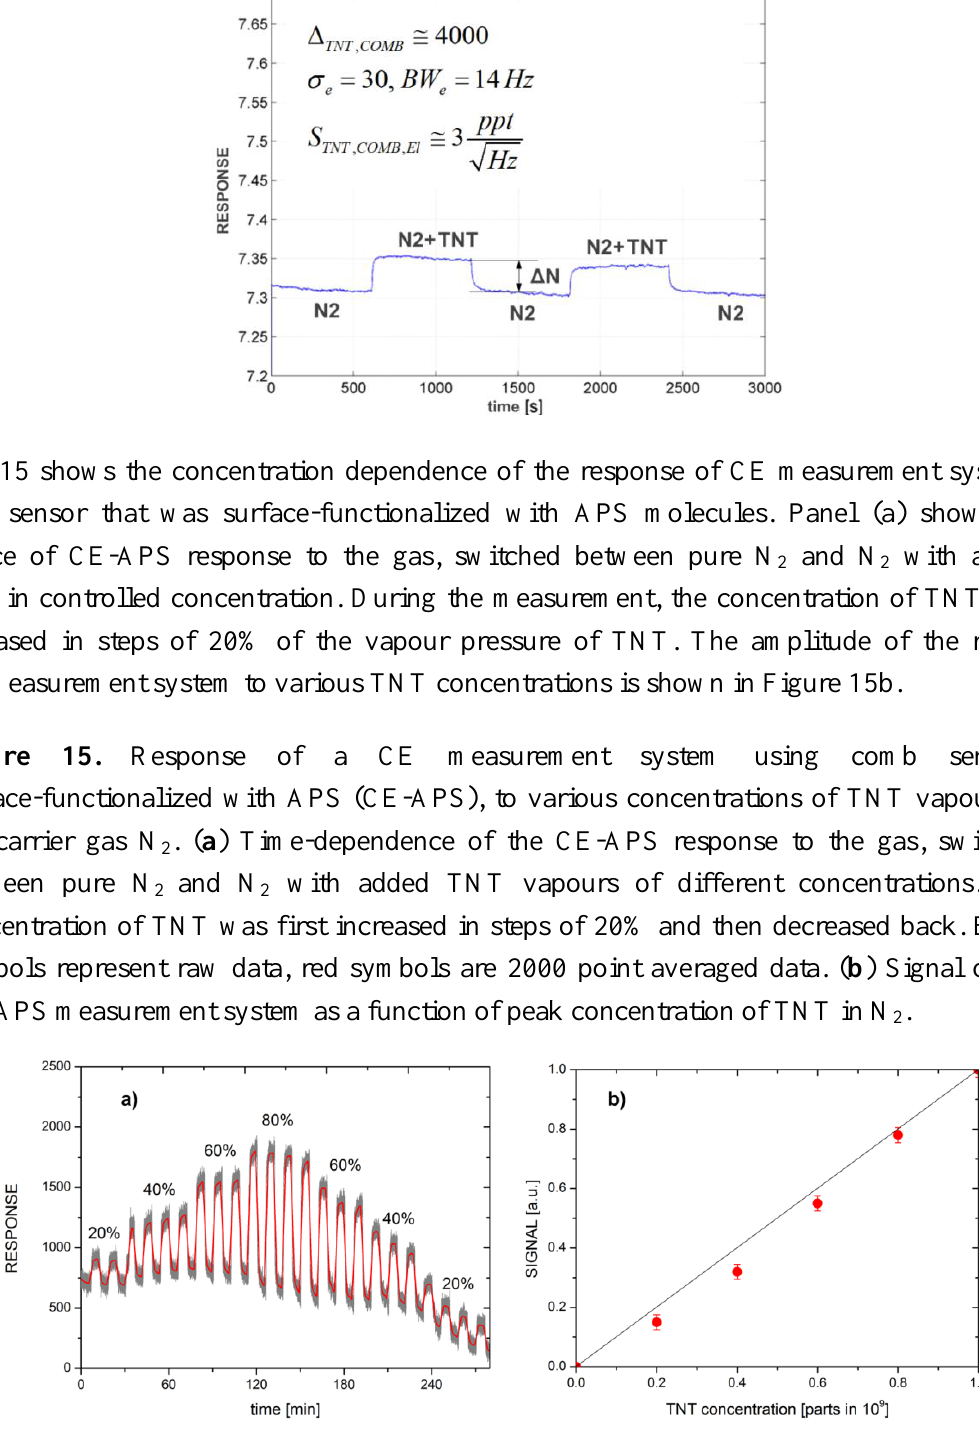
Figure 14. Measured response of a CE (Comb capacitive sensor with Electronic detection) surface-functionalized with APS molecules, to the gas, switched between pure N contaminated with 50% vapour pressure of TNT at room temperature. The normalized sensitivity of the sensor and the measurement system to the vapour of TNT is approximately 3 × 10 −12 . The RESPONSE is dimensionless and represents the number at the output of the DSP that is proportional to the relative change of the capacitance δ